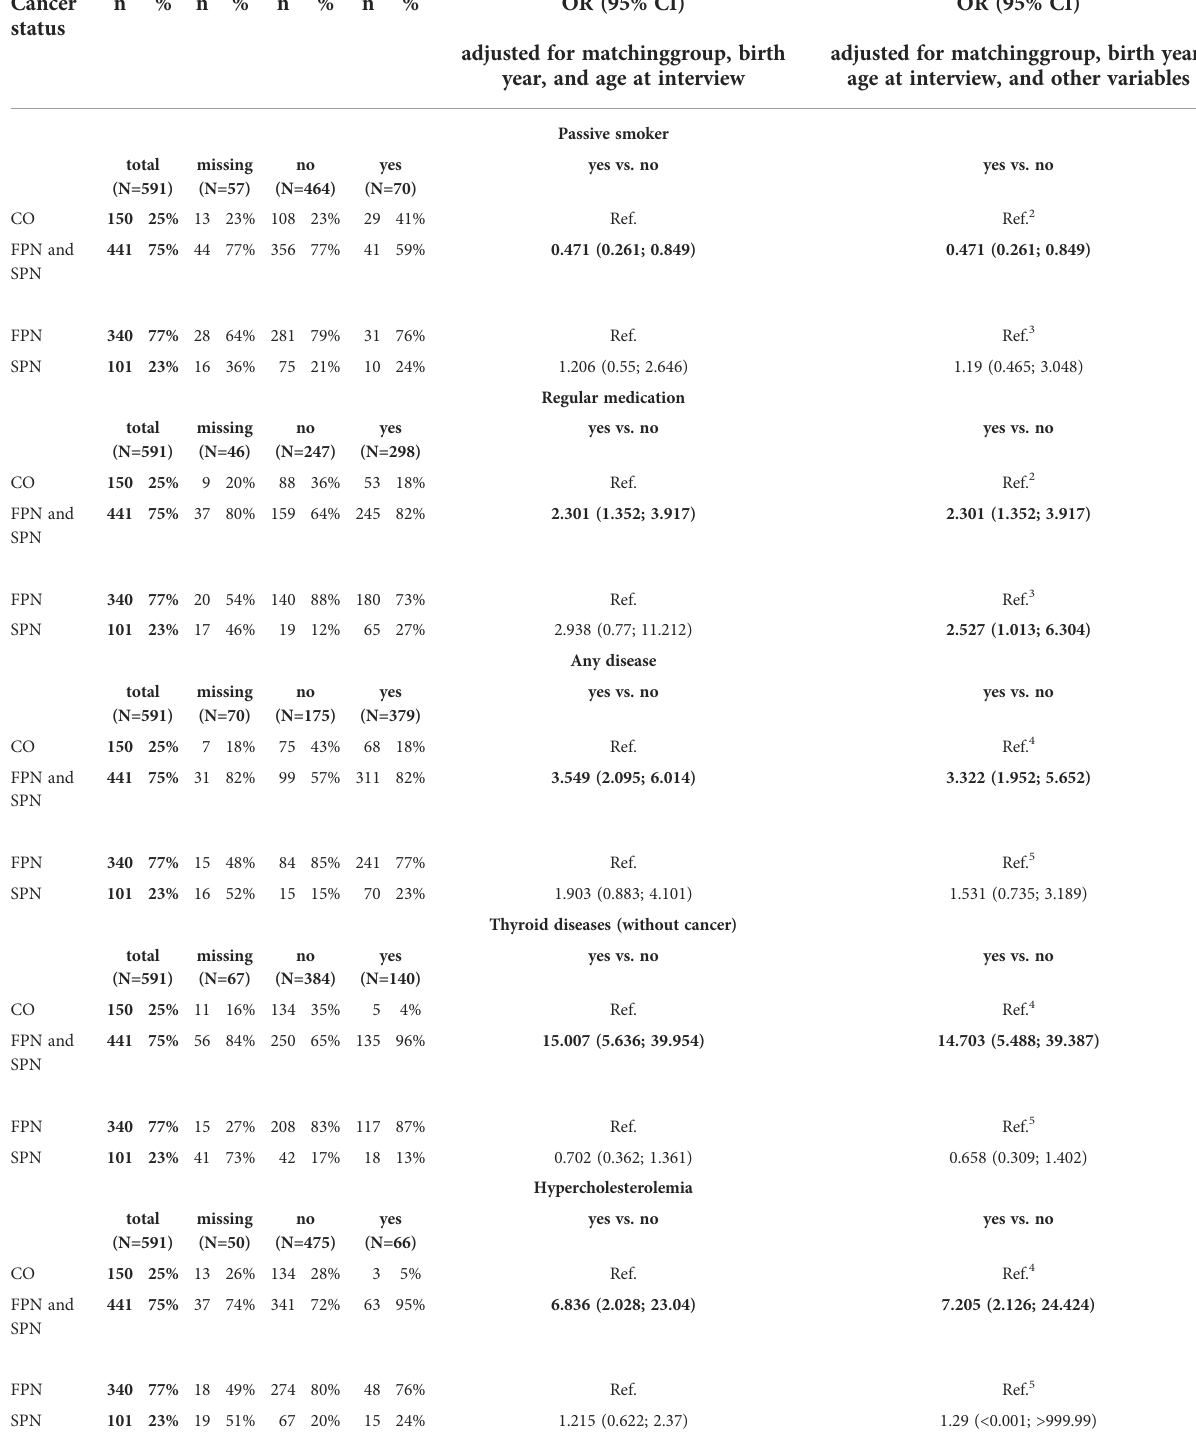
TABLE 4 Comparison of serum IL-4, PGE2 and AGEs in each